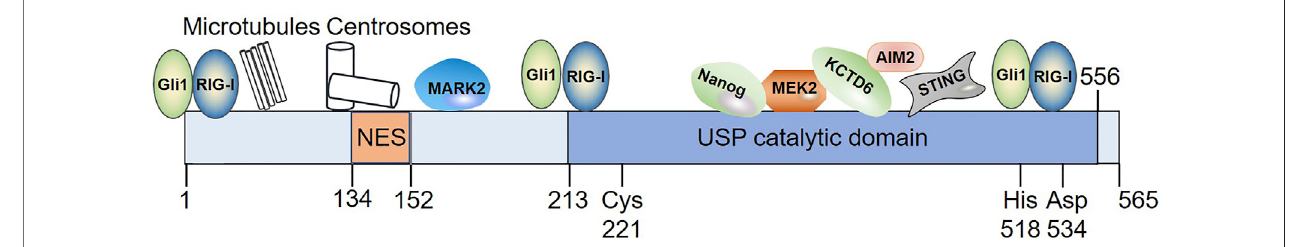
FIGURE 2 | Diagram illustrating the domain organization of USP21 as well as its interaction with substrates whose binding domain in USP21 have been de fi ned. Among these interacting partners, Gli1 and RIG-I bind to multiple regions of USP21. NES spans residues 134 – 152; Cys221, His518, and Asp534 indicates the position of its catalytic residues. NES, nuclear export